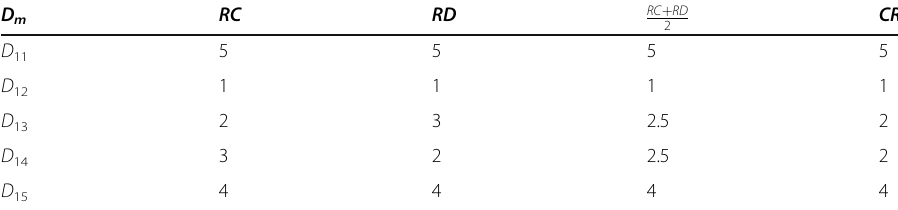
Table 11 A composite rank measure produced by averaging RC and RD D m RC RD RC þ RD